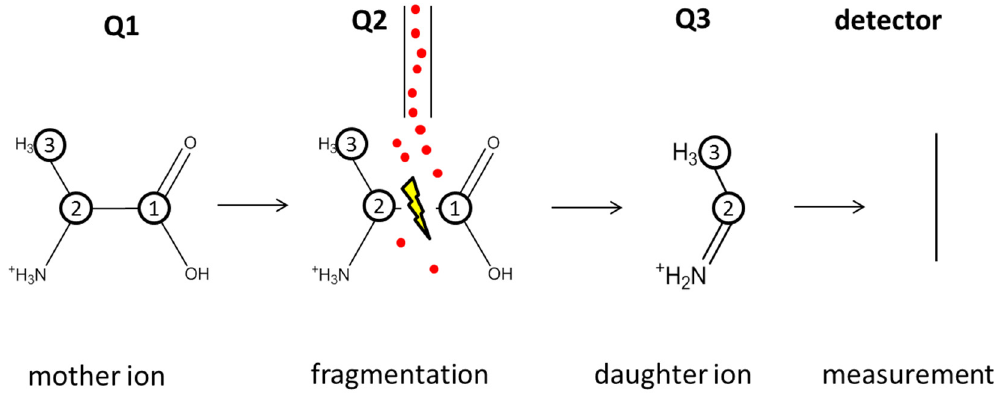
Figure 6. Selection and fragmentation of an ionized alanine molecule in the used triple quadrupole MS. The circled numbers indicate the carbon atoms of the alanine molecule derived from the carbon position of the substrate glucose; the red dots symbolize the inert gas particles (N 2 ) for collision with the mother